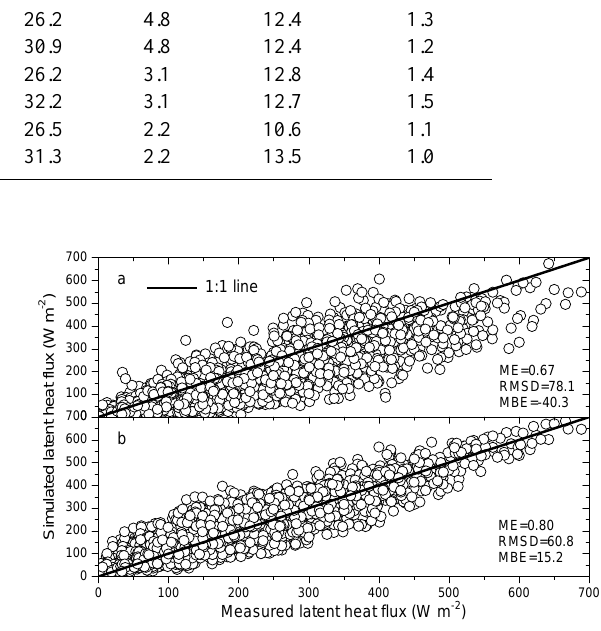
Fig. 7. Comparison between the measured and the simulated half- hourly evapotranspiration by P-M model using the J-D (a) and the N-P (b) bulk canopy resistance